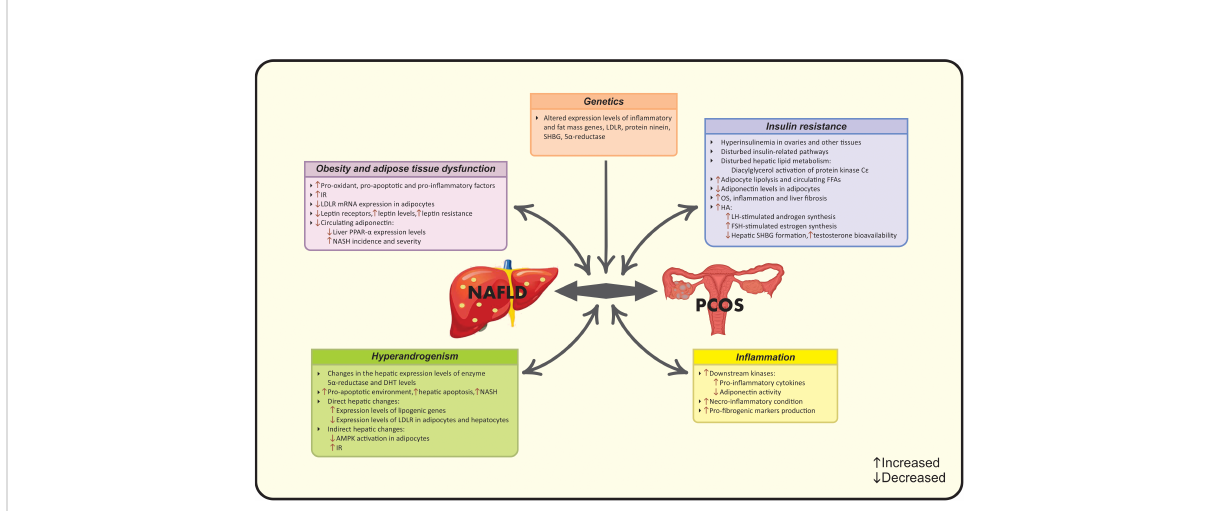
Dihydrotestosterone; FFA, Free fatty acid; FSH, follicle-stimulating hormone; HA, Hyperandrogenism; IR, Insulin resistance; LDLR, Low-density lipoprotein receptor; LH, Luteinizing hormone; NAFLD, Nonalcoholic fatty liver disease; NASH, Non-alcoholic steatohepatitis; OS, Oxidative